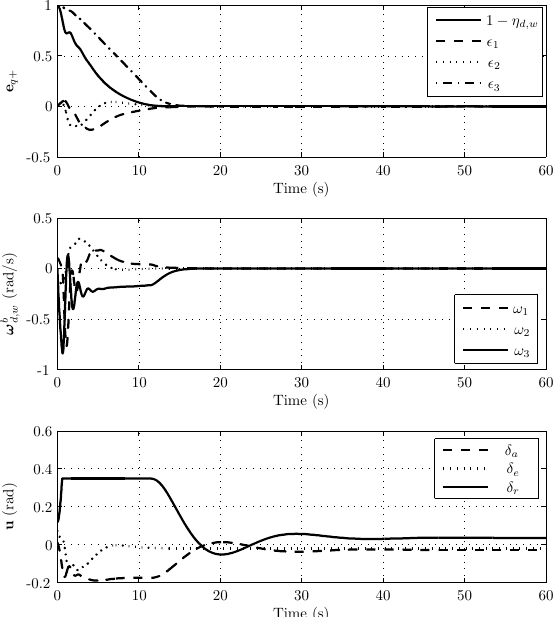
Figure 4: Rotational dynamics of the uav